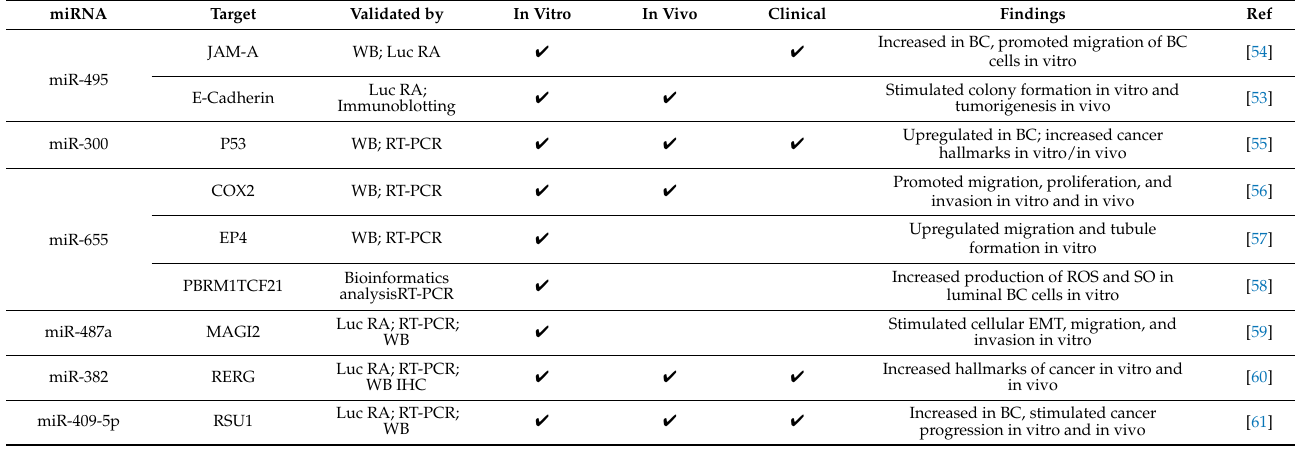
Table 2. OncomiRs of the C14MC in breast